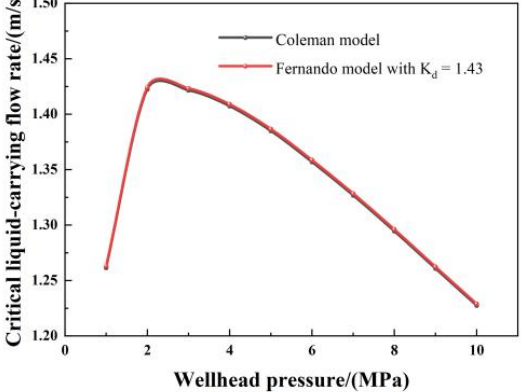
Figure 2. Drag coefficient for the inclined section determined using the Turner and Fernando mod- els.